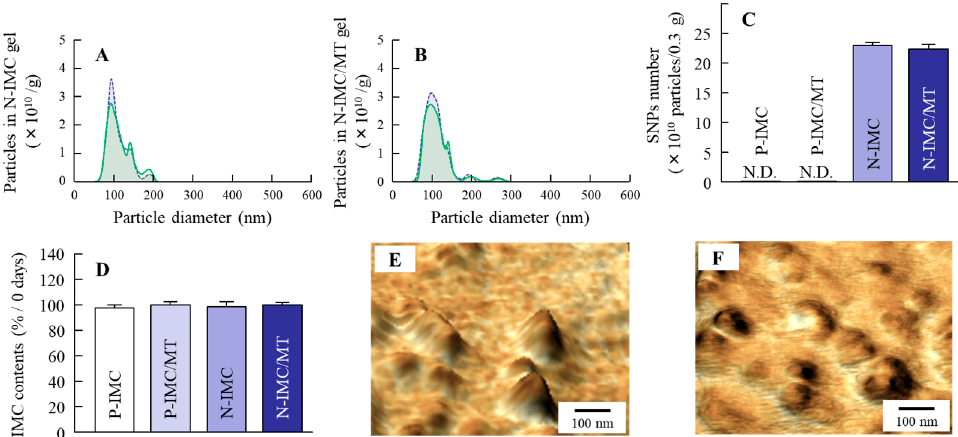
Figure 3. Particle analysis of N-IMC and N-IMC/MT gels 1 month after preparation. ( A and B ); Particle size frequencies in N-IMC ( A ) and N-IMC/MT ( B ) gels immediately (blue) and 1 month (green) after preparation. ( C ); the number of SNPs in IMC transdermal formulations. ( D ); the changes in IMC content in the transdermal formulations. E and F ; AFM images of SNPs in N-IMC ( E ) and N-IMC/MT ( F ) gels. n = 6–10. The IMC particle size of SNPs-based transdermal formulations were not changed 1 month after preparation, and the particle sizes in the N-IMC and N-IMC/MT gels were 109.8 ± 6.9 nm and 115.3 ± 7.1 nm, respectively.